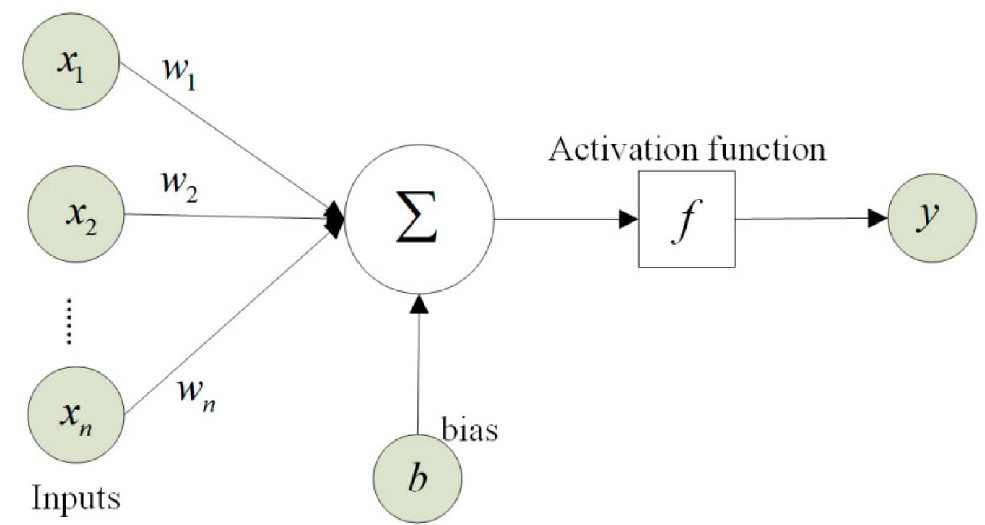
Figure 3. Visual representation of Neuron’s Calculation operations [31].